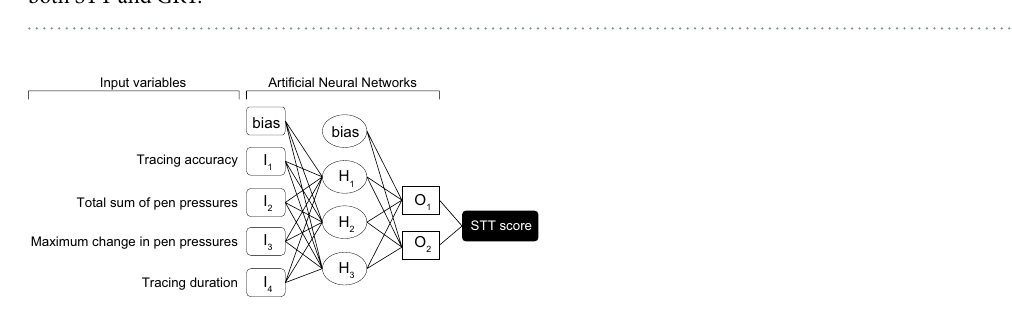
Figure 3. Digitized traced line. The solid line shows the trajectory of the pen tip moved by a CSM patient during the test. The dotted line shows original, sine-wave curve. This patient was judged as a CSM patient in both STT and GRT.